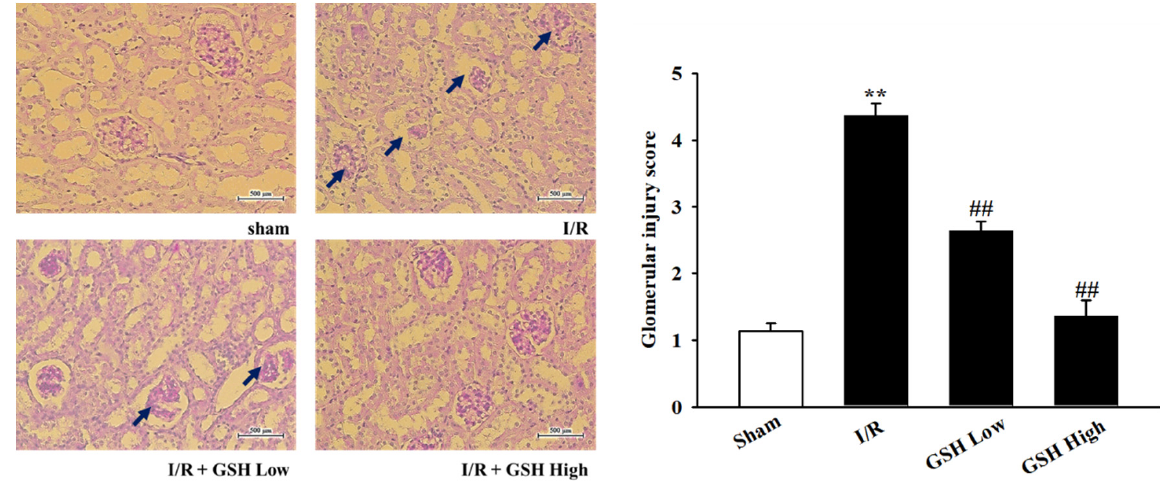
Figure 2. Effect of GSH on renal injury. Representative photomicrographs showed PAS-stained tissues (magnification 200 × , scale bar: 500 µ m). Right bar graph indicates the quantitative assessment of glomerular injury. ## p < 0.01 vs. sham group; ** p < 0.01 vs. I/R group.